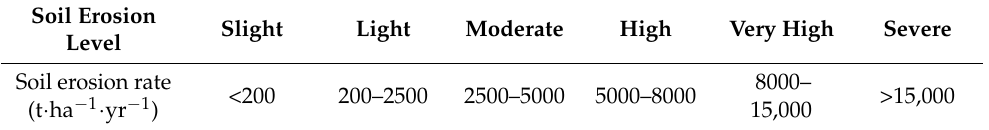
Table 2. The standard for soil erosion